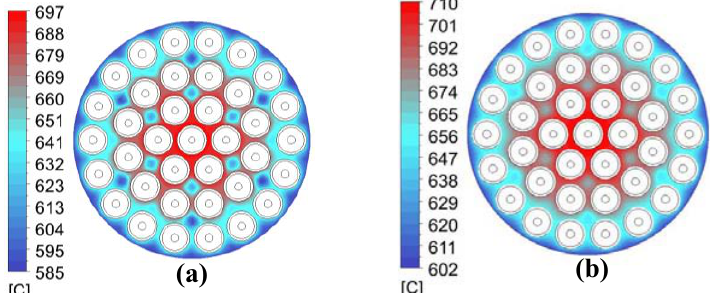
Figure 9: Temperature distribution of the argon gas inside the channel: (a) section C (b) section D